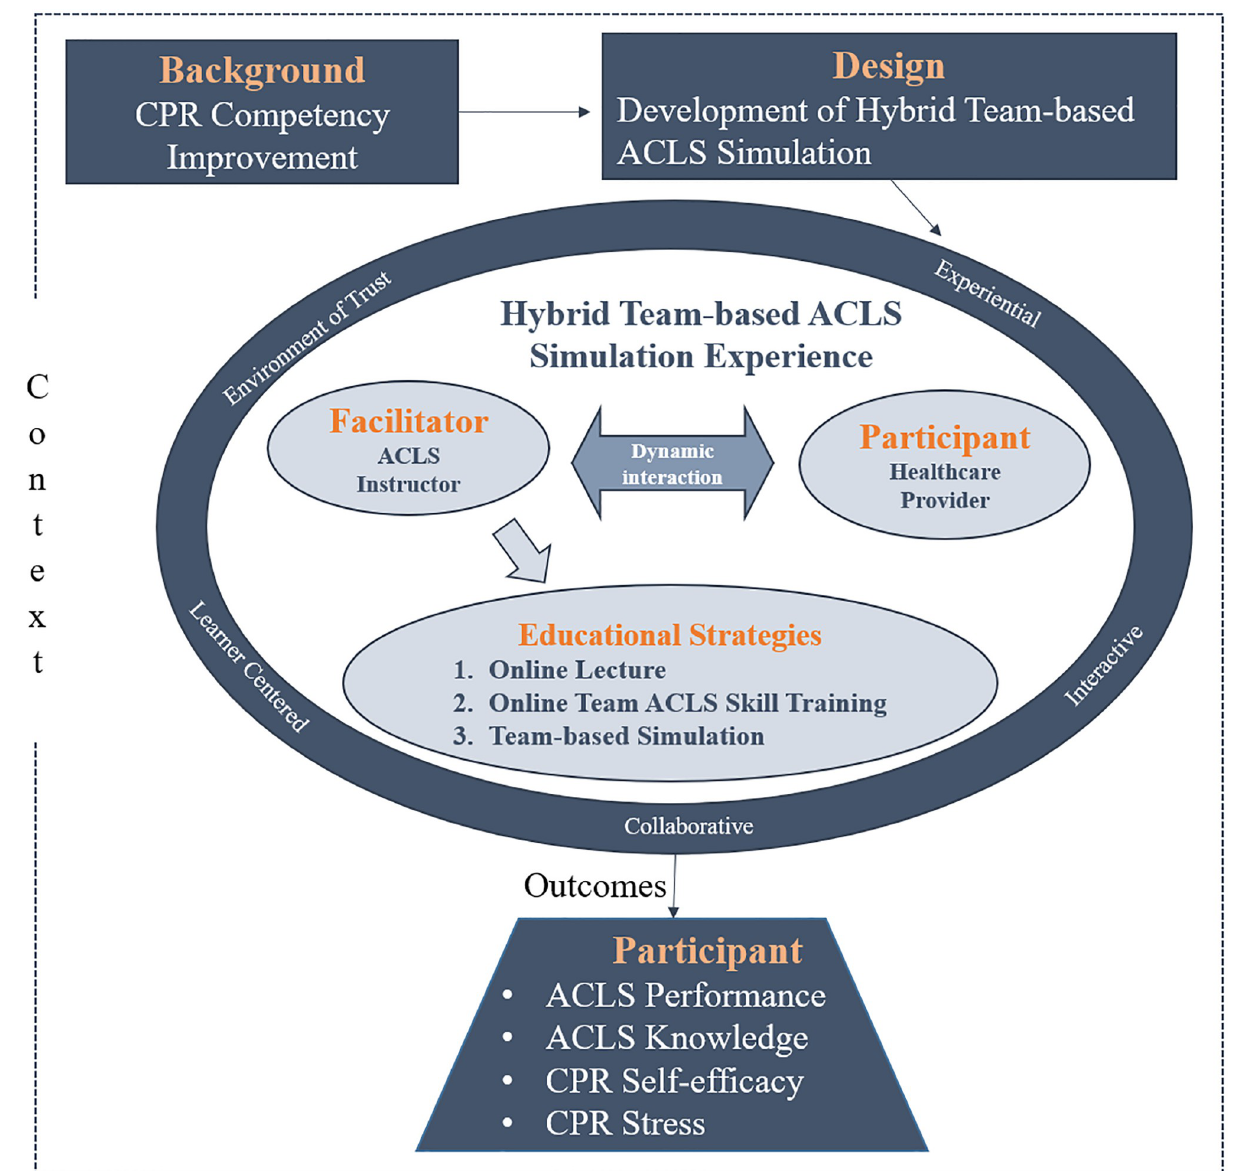
Fig 1. Conceptual framework of this